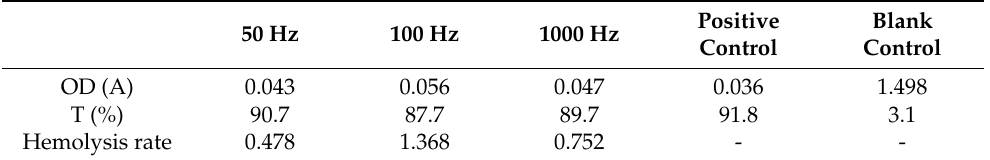
Positive Blank Control Control